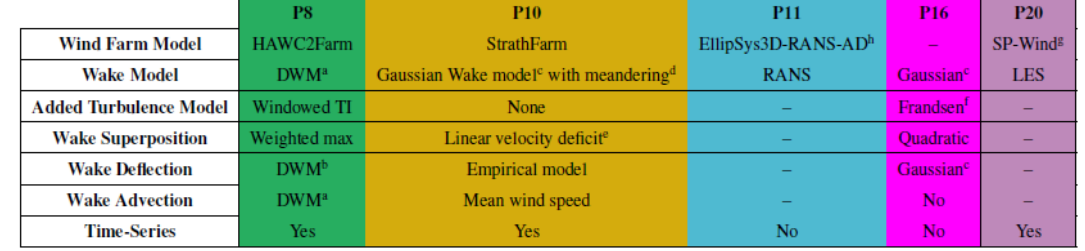
Table 9. Overview of the participating WFFC-oriented models, TotalControl LES blind test. a Larsen et al. (2008) and Madsen et al. (2010). b Larsen et al. (2020). c Bastankhah and Porté-Agel (2016). d Poushpas (2016). e Niayifar and Porté-Agel (2016). f Frandsen (2007) –